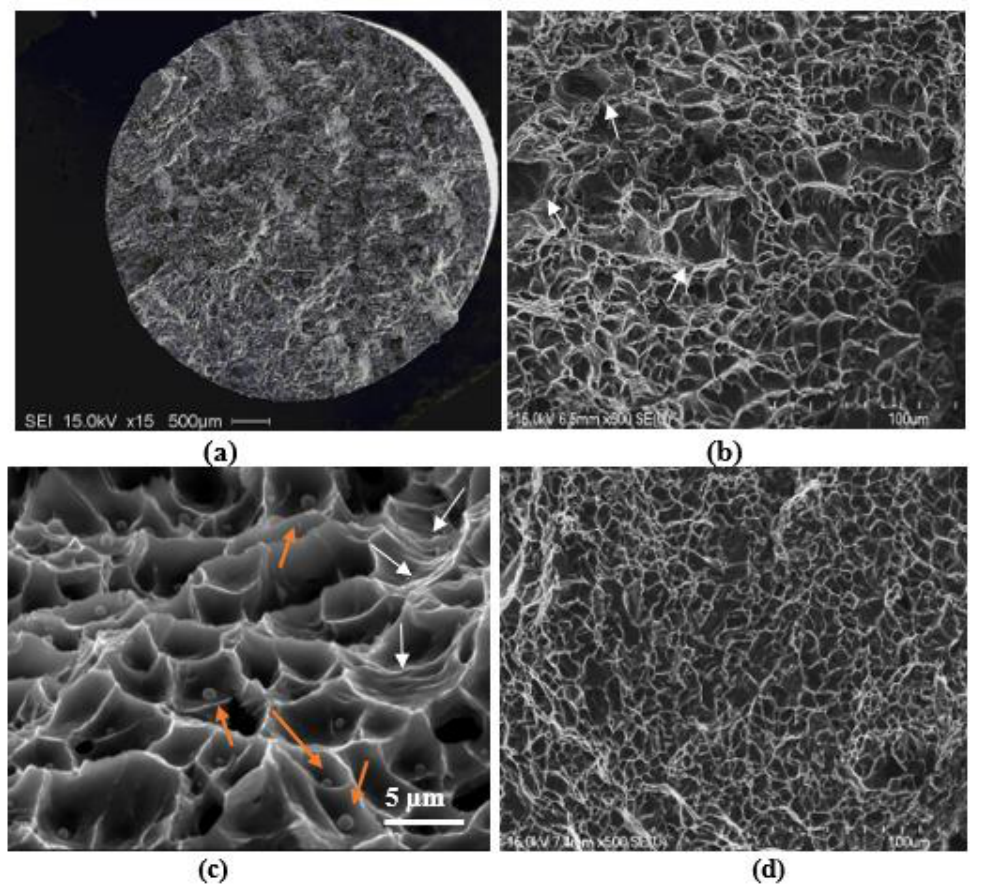
Figure 16. SEM of the fracture surface of alloy A under different conditions: ( a ) as-cast-general view, ( b ) high-magnification view of the central portion, ( c ) following solution heat treatment, and ( d ) in the T6 condition (20 h at 155 °C corresponding to maximum UTS level). Note the presence of spherical Si particles at the bottom of the dimples in ( c ) orange arrows, and slip bands, white arrows.